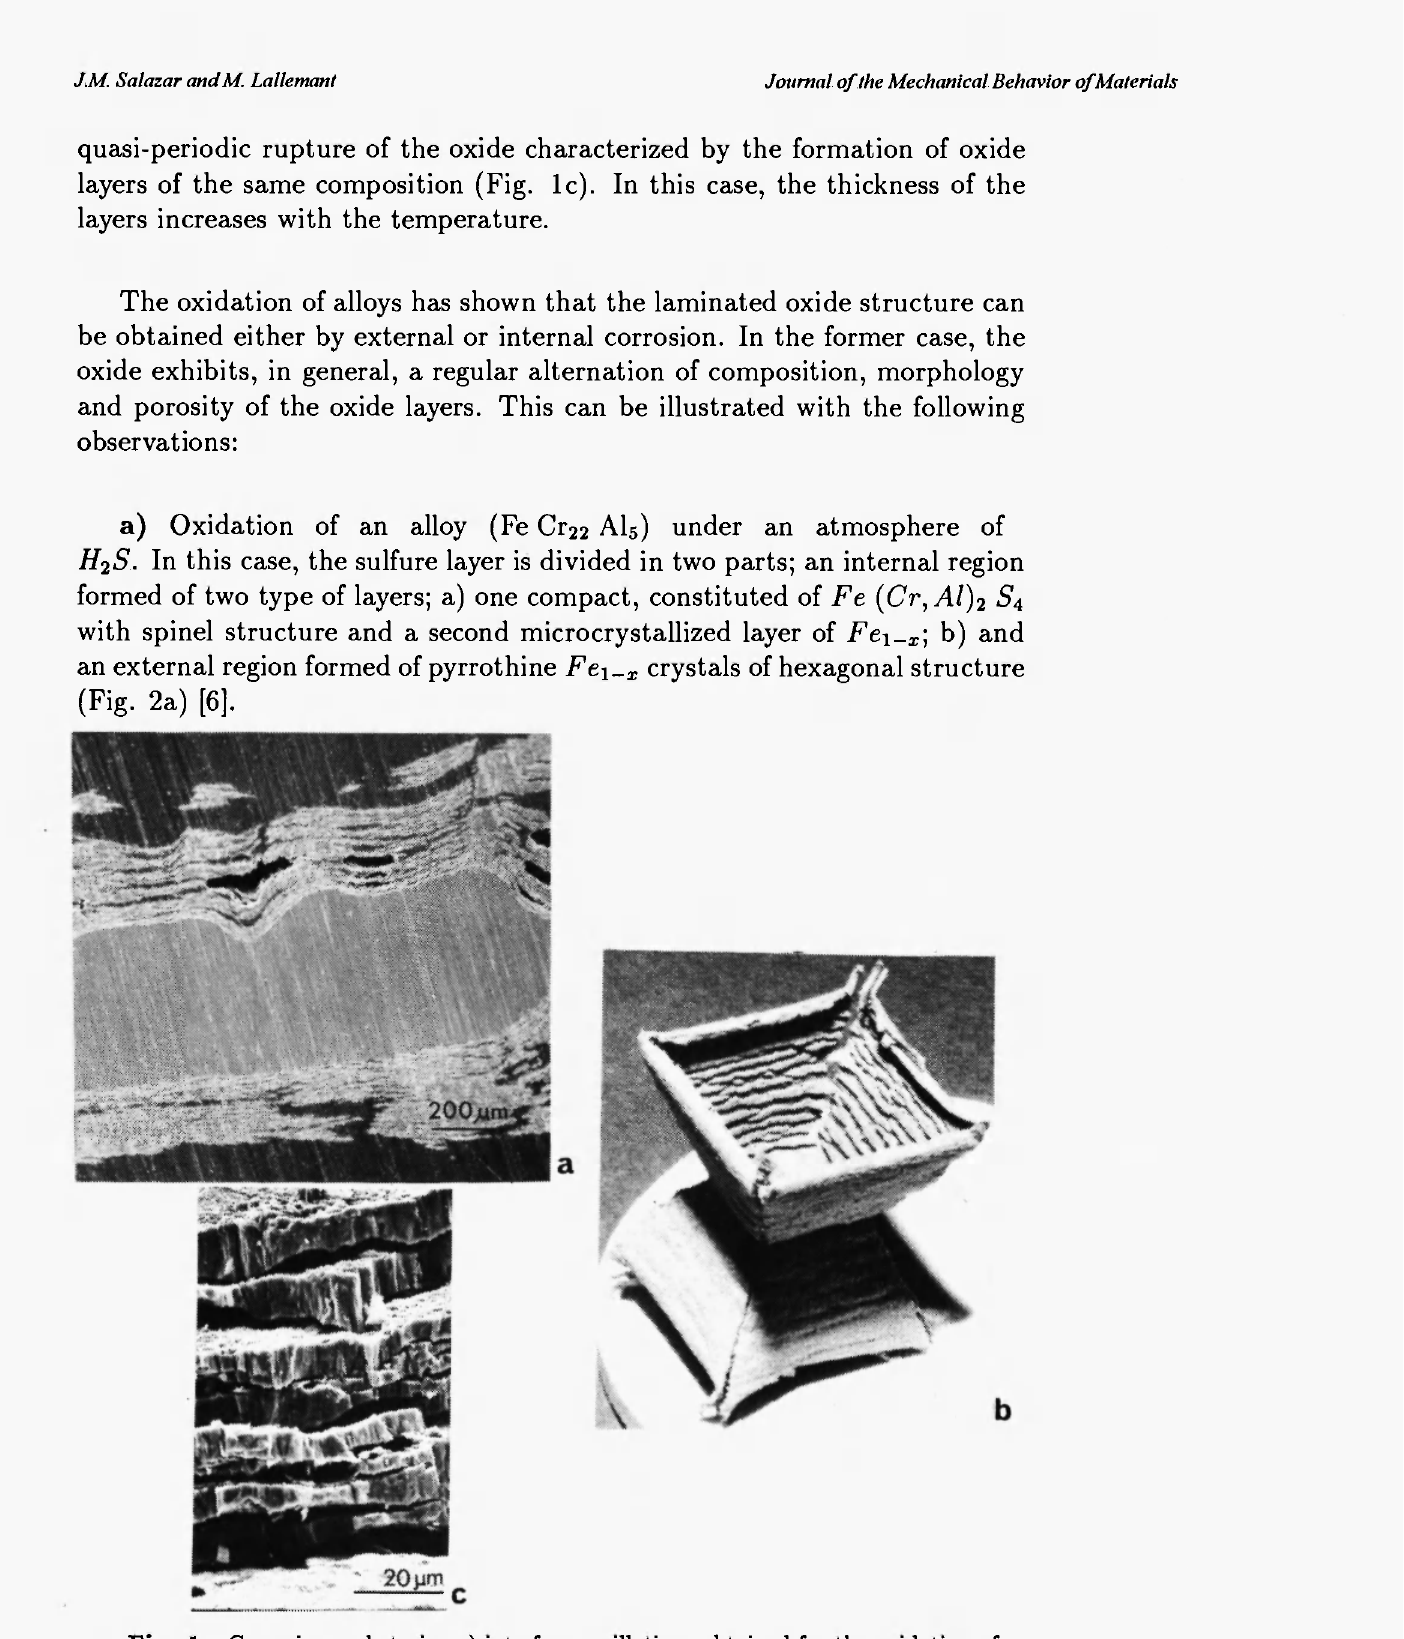
Fig. 1 : Corrosion and strain, a) interface oscillations obtained for the oxidation of Ti-Zr. b) oxidation of Nb; showing the diabolo's morphology, c) periodic rupture of the oxide layer during the oxidation of